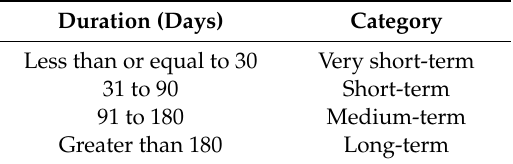
Table 2. Drought classification based on the drought